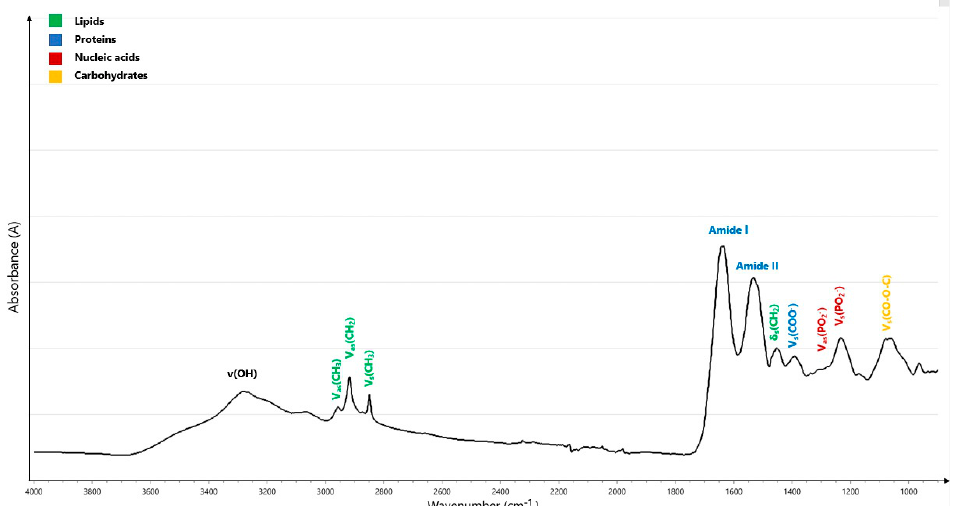
Figure 1. Typical MIR spectrum measured using attenuated total reflection–Fourier transform infrared (ATR–FTIR) spectroscopy of a biological sample showing peak assignments from 4000 to 800 cm − 1 . V: stretching vibrations, δ : bending vibrations, s: symmetric vibrations, as: asymmetric vibrations. Table 1. Overview of the use of the mid-infrared spectrum in the molecular characterization of proteins. Biomolecule Spectral Region (cm − 1 ) Functional Group Assignment Amide A 3310 and 3270 cm − 1 N-H stretching Amide I ~1650 cm − 1 C=O stretching C-N stretching Amide II ~1550 cm − 1 N-H in-plane bending C-N stretching Amide III 1400–1200 cm − 1 N-H in-plane bending C=O in-plane bending